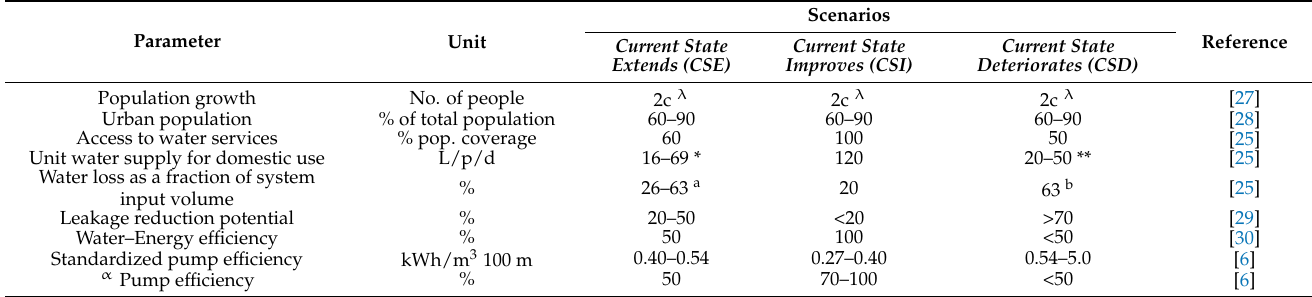
Table 2. Selected quantifiable parameters applied for the three plausible